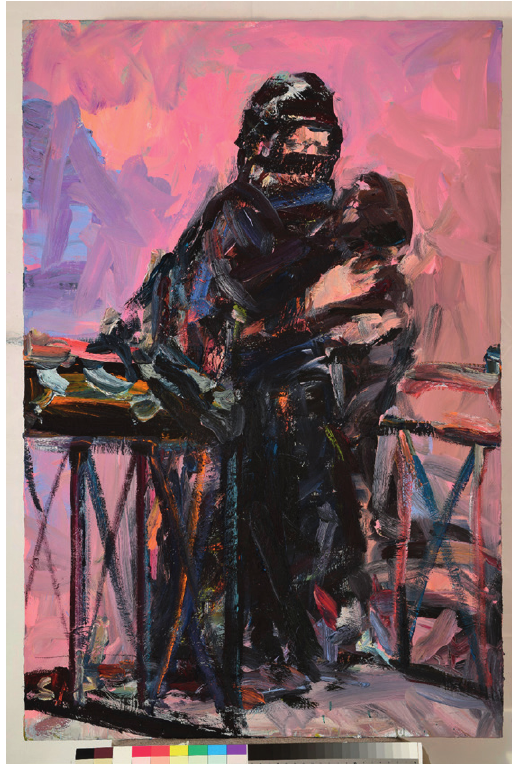
Figure 2. Sigita Maslauskaitė-Mažylienė. Refugee